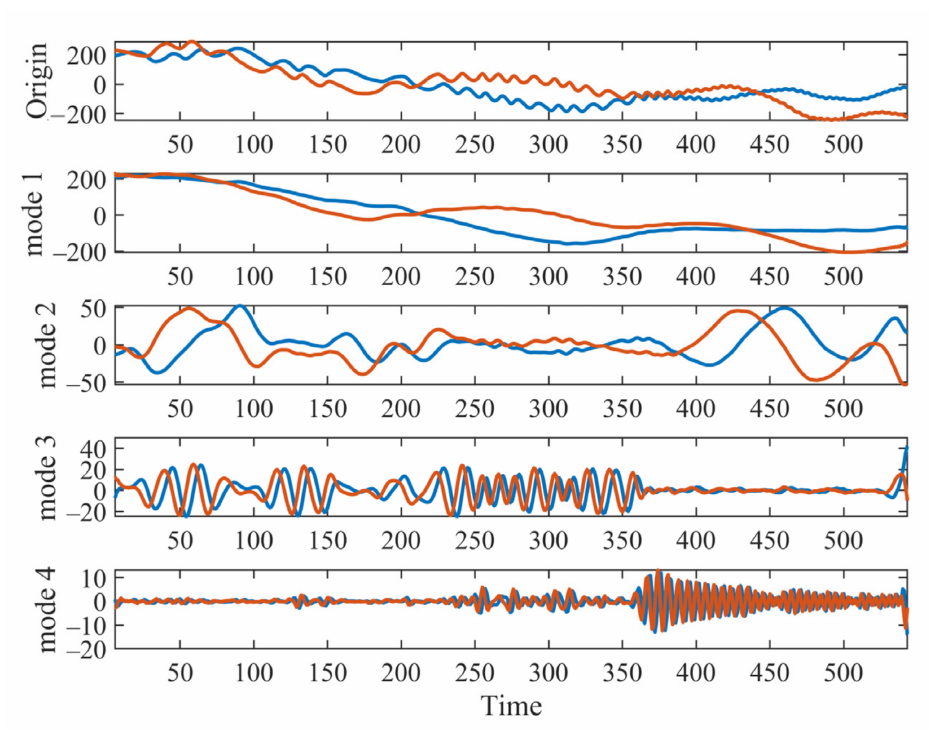
Figure 11. The time–domain waveform of the original drifting float signal and its MCVMD decompo- sition. From top to bottom: original signal, decomposed mode 1, decomposed mode 2, decomposed mode 3, and decomposed mode